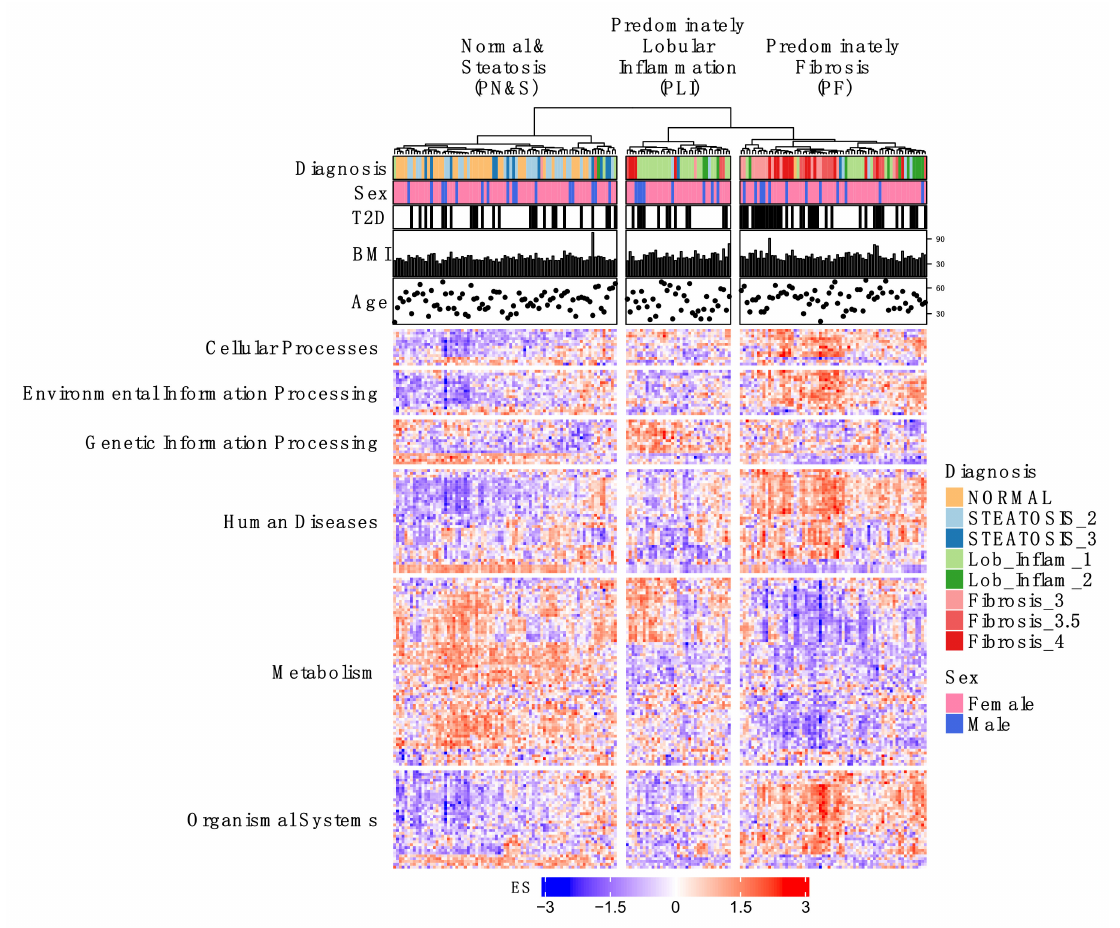
Figure 2. Individual patient liver transcriptome analysis yields distinct clusters based on their Kyoto Encyclopedia of Genes and Genomes (KEGG) pathway enrichment profiles. The heatmap shows the hierarchical clustering of the liver KEGG pathway enrichment profiles ( columns ) from individual patients, determined by RNA sequencing and gene set variation analysis (GSVA) using MSigDB v7.0 C2 KEGG pathways [24] (see Methods). Pathways ( rows ) are grouped according to the top-level KEGG hierarchical classifications (labeled along the left ordinate) to which they belong. The color represents the enrichment score (ES; see the color-coded bar under the heatmap), which reflects the degree to which a pathway is over- or under-represented within that individual patient sample (see [25]). The plots above the heatmap show the patient metadata: the top two bars indicate the color-coded diagnosis (see panel on the right ) and patient sex, the third indicates if the patient has been diagnosed with type 2 diabetes (T2D) ( black bars ), and the additional two plots show the body mass index (BMI) and age of the patient. The clinical subtype distribution for each of the three clusters (PN&S, PLI, PF) is shown in Table S2. More details on this analysis, including the specific pathway information and patient metadata, can be found in the associated R notebooks